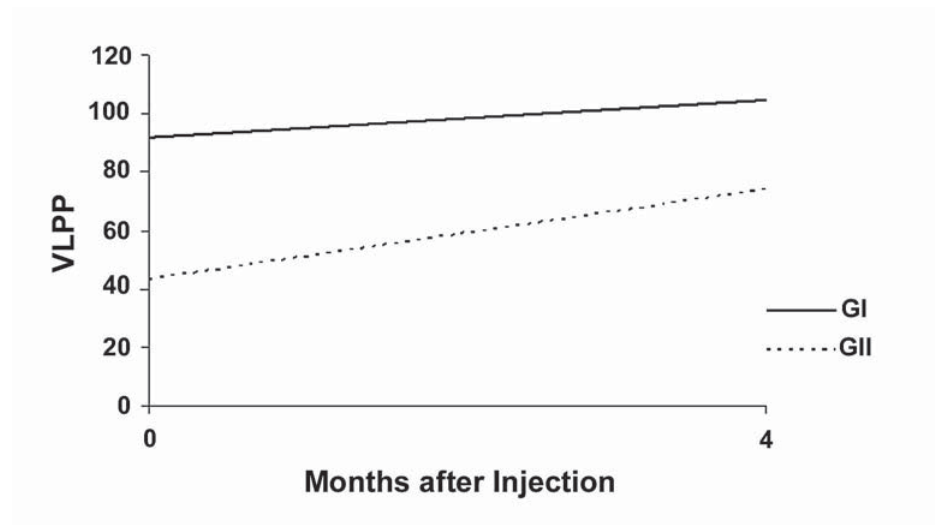
Figure 3 – Behavior of Valsalva leak point pressure before and after treatment with periurethral injection.GI: Kruskal-Wallis test: p > 0.05, GII: Kruskal-Wallis test: p <